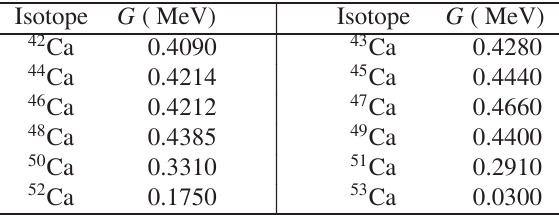
Table 1. Pairing interaction strength G deduced from experiment for the 42 − 53 Ca isotopes.